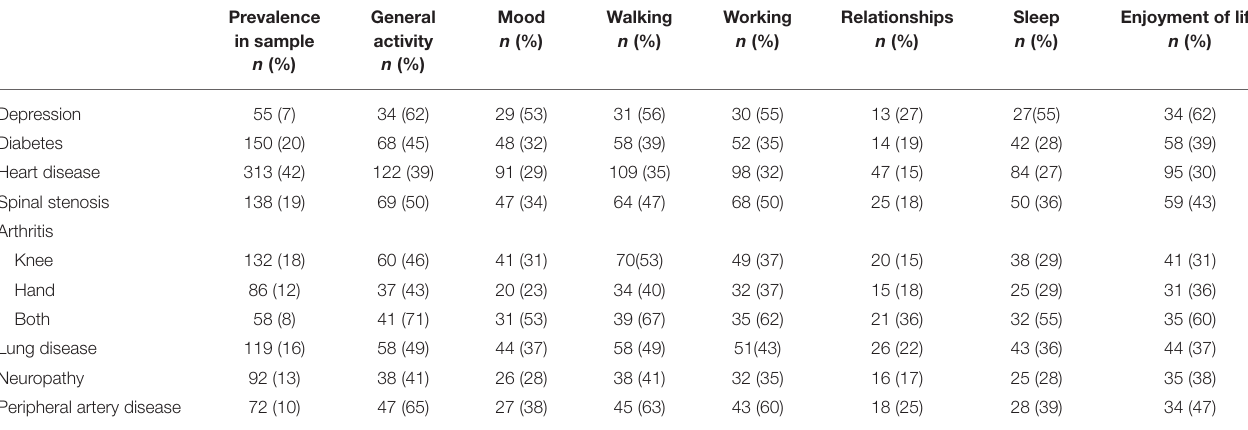
TABLE 2 | Prevalence of moderate-severe PI ( > 2 PI) according to chronic conditions, MOBILIZE Boston